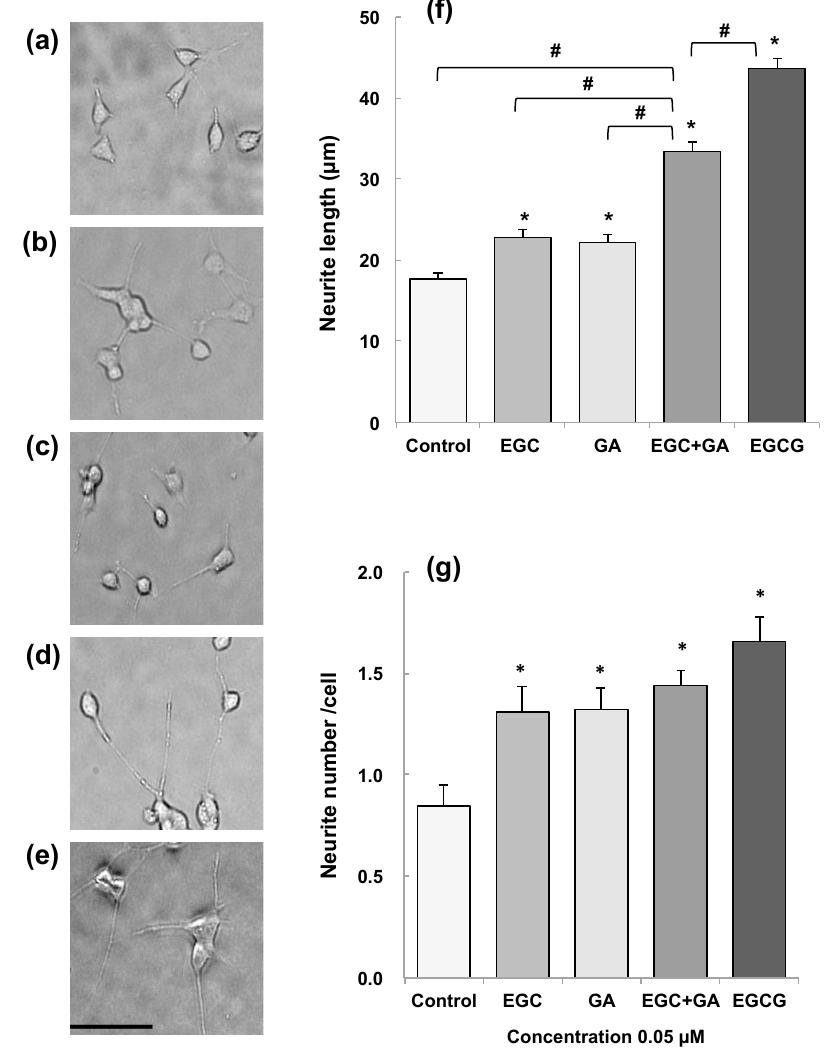
Figure 2. Effect of EGCG, EGC, and gallic acid (GA) on neurite outgrowth of human neuroblastoma SH-SY5Y cells [62]. EGCG, EGC, and GA dissolved in 0.01% dimethylsulfoxide were added to the culture medium to make a final concentration of 0.05 μ M and cultured for 72 h at 37 °C. Photos of ( a ) control cells and ( b ) cells treated with EGC, ( c ) GA, ( d ) EGC and GA, and ( e ) EGCG. ( f ) Neurite length and ( g ) neurite number of cells treated with catechins. Scale bar is 50 μ m. Each value represents the mean ± SEM. Asterisks and # represent significant differences with the control (*) and with EGC and GA (#) ( p < 0.05, Bonferroni’s t -test). Reproduced under Creative Commons Attribution-Noncommercial-No Derivatives License (CC BY NC ND). doi:10.1016/j.bbrep.2016.12.012.